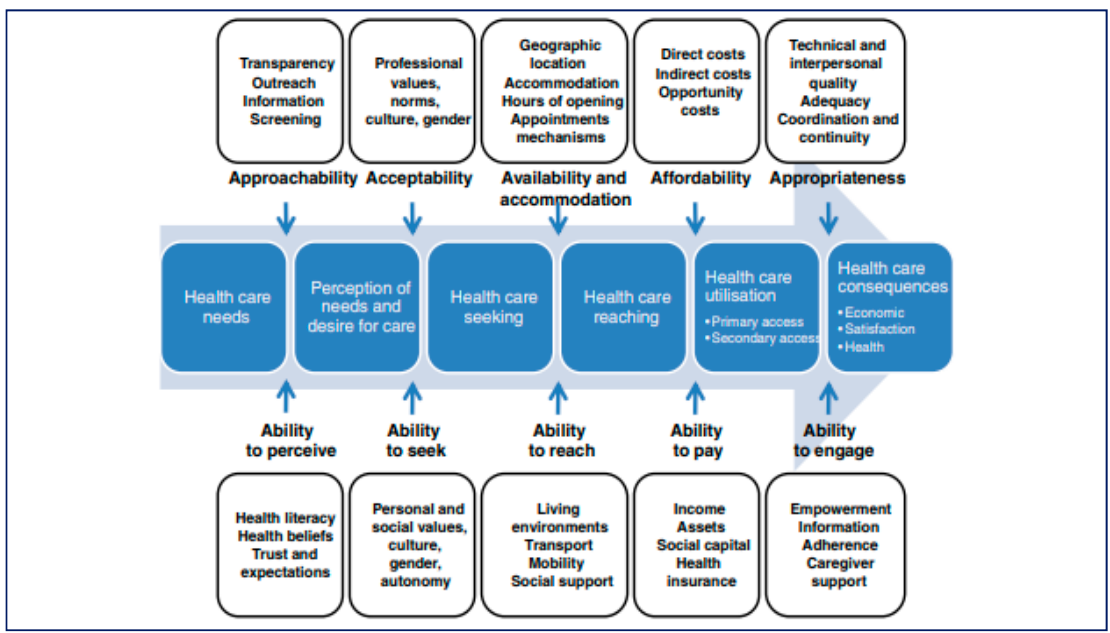
Figure 3. A framework of access to care conceptualised by Levesque et al [52].